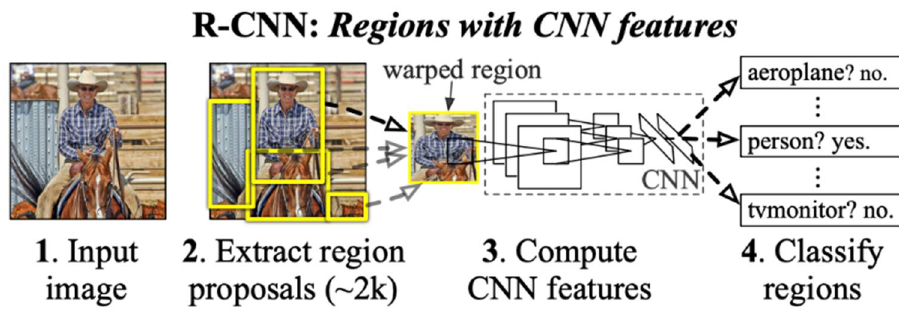
Figure 1. R-CNN flowchart. CNN: convolutional neural network.